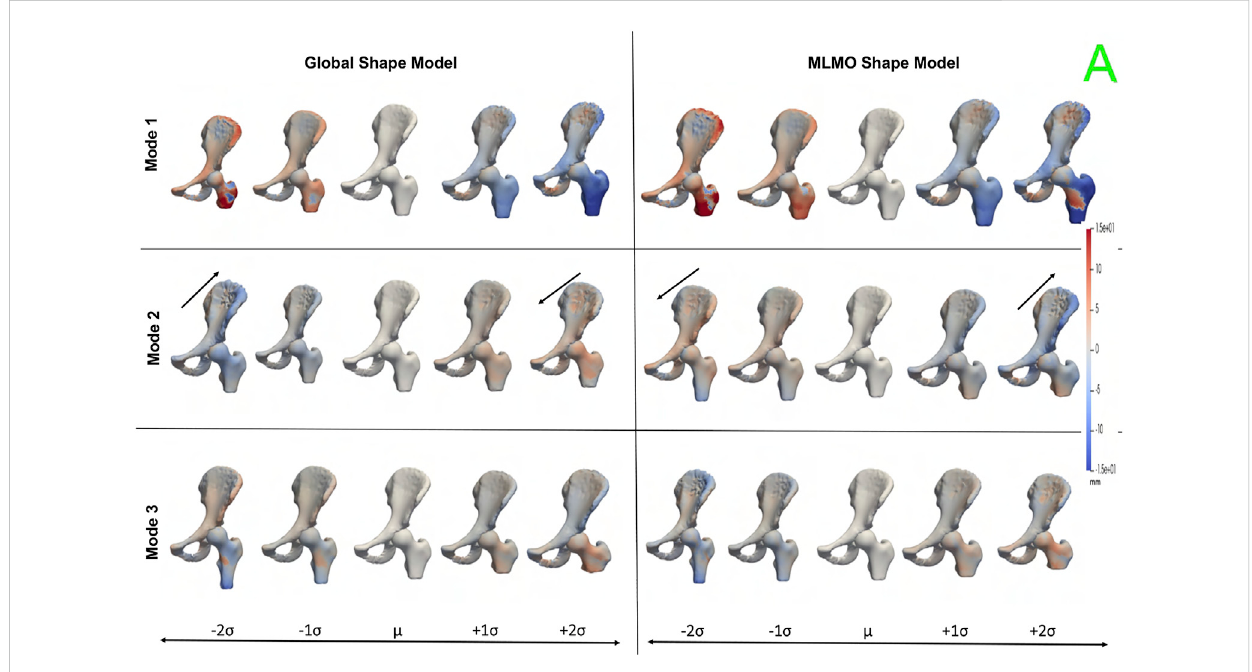
FIGURE 10 PCA modes of variation inthe shared subspace for thehipjointdataset. The colormap shows the distance ofeach mode from themean shape. The arrows denote the direction along which major shape variations take place.